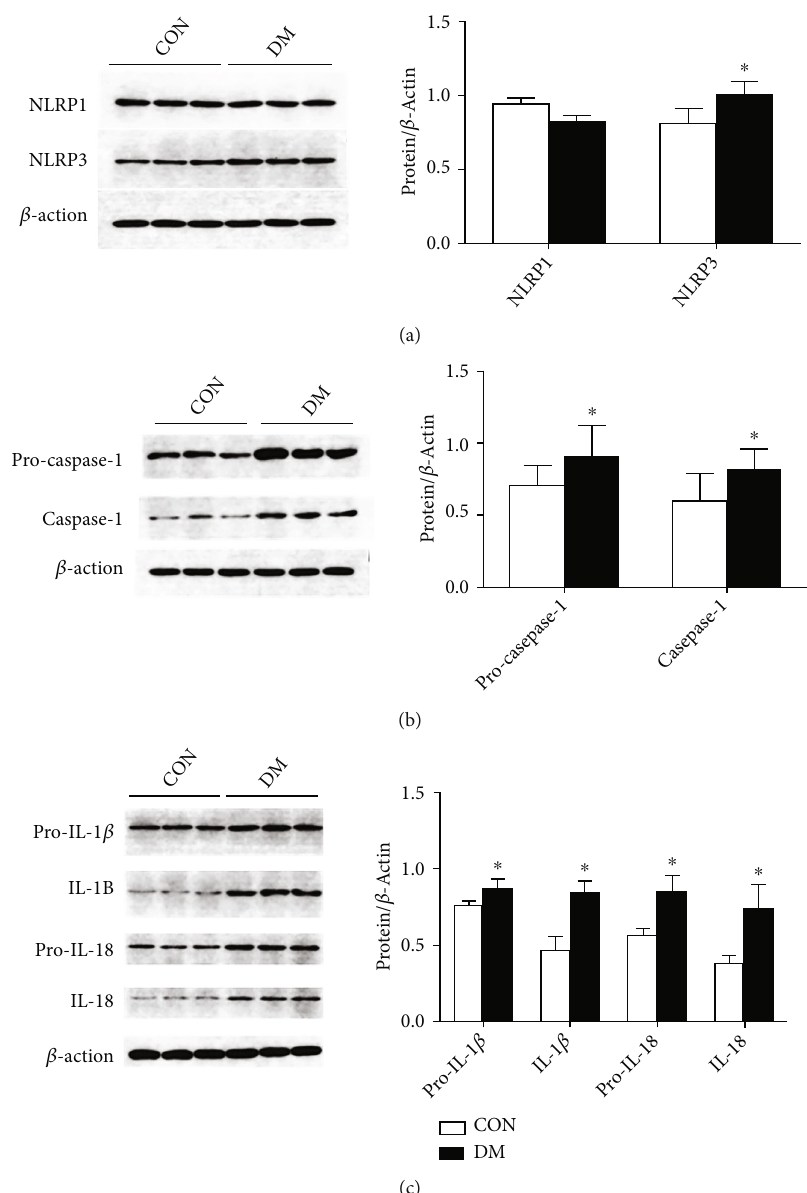
Figure 3: Expression of the NLRP subfamily and downstream molecules was analyzed by Western blots in kidney tissues from diabetic minipigs. (a) Detection of NLRP subfamily members ’ expression by Western blots and semiquantitative analysis of the expression levels of NLRP subfamily members. (b) Detection of procaspase-1 and caspase-1 expression by Western blots and semiquantitative analysis of the expression levels of procaspase-1 and caspase-1. (c) Detection of downstream cytokine expression by Western blots and semiquantitative analysis of the expression levels of downstream cytokines. Protein expression data are presented as the means ± SD . ∗ P < 0 : 05 versus